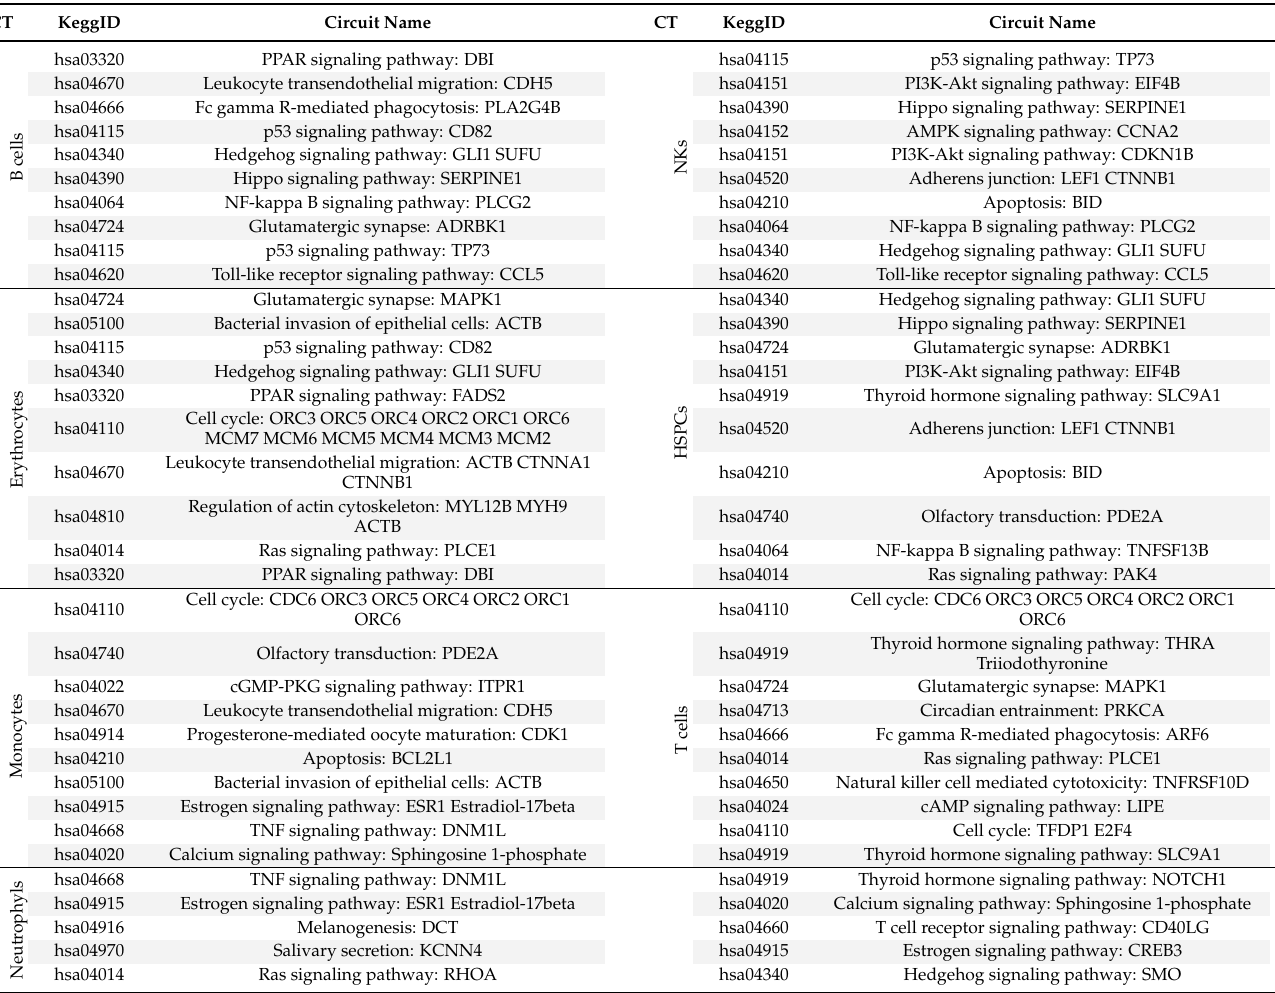
Table A2. List of the most relevant signaling circuits (defined as pathway:effector protein) for each cell type in the Immune